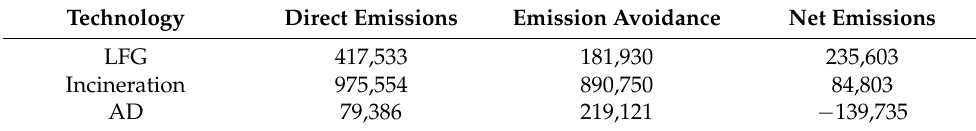
Table 8. GHG emissions and emission saving from WTE technologies (tCO 2 -eq/year).